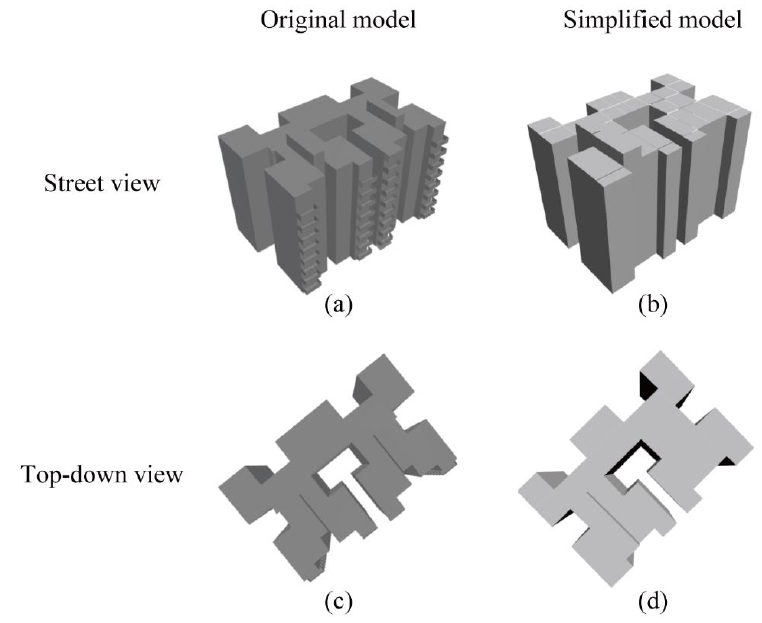
Figure 10. Simplification of a 3D building with flat roofs: ( a ) original model in street view; ( b ) simplified model in street view; ( c ) original model in top-down view; and ( d ) simplified model in top-down view. Table 1. Data volume comparison for original and simplified 3D building in LOD3.